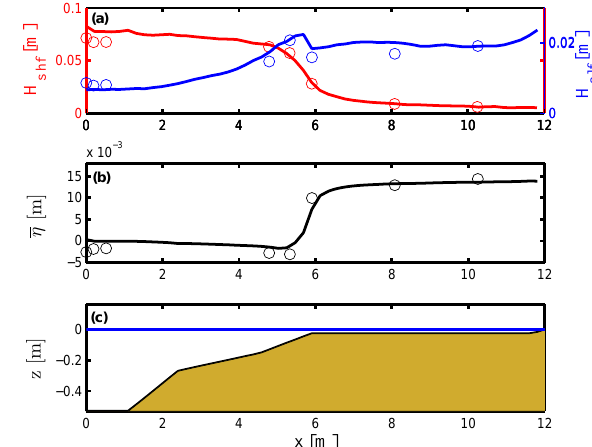
Fig. 4. Numerical model setup and results: (a) High- (red open- circles: observations; red solid line: model prediction) and low- frequency significant wave height (blue open-circles: observations; blue solid line: model prediction) as a function of cross-reef po- sition for Test 29 ( H s = 7 . 1cm and T p = 1 . 5s). (b) Wave-induced setup (black open circles: observations; black solid line: model pre- diction). (c) Reef-profile.